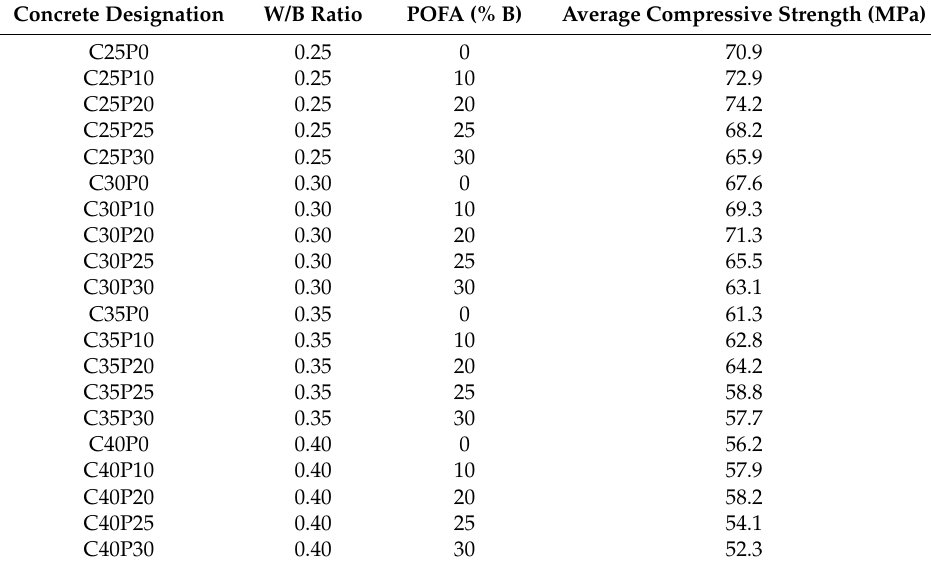
Table 3. Compressive strength of different SCHSC mixes at the age of 28